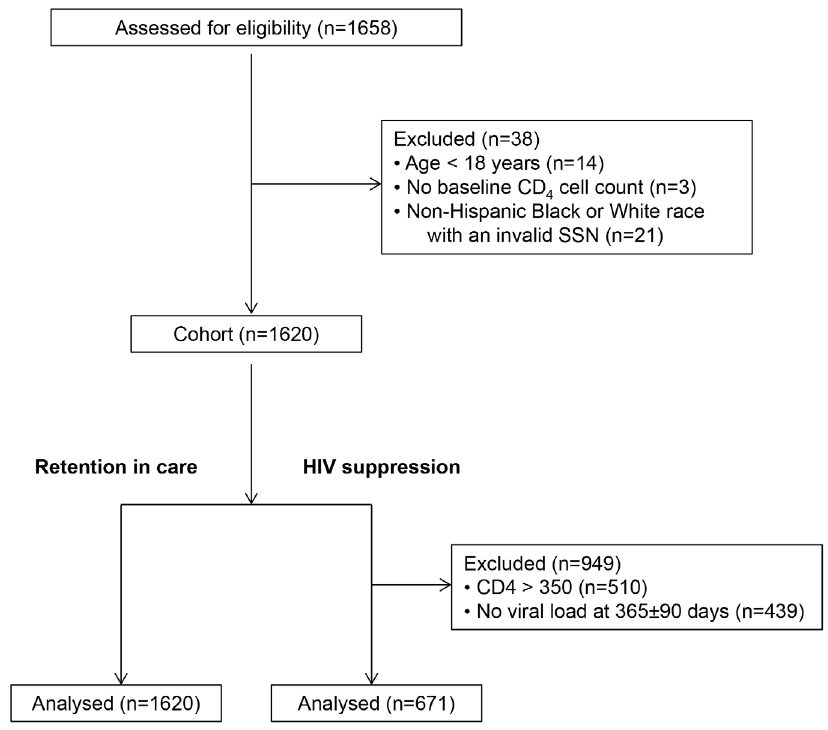
Figure 1. Flow Diagram.